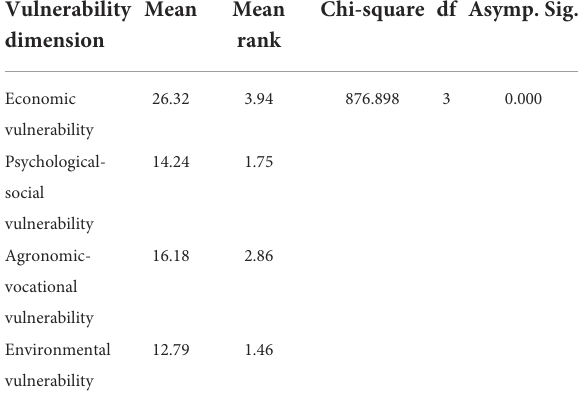
TABLE 6 The comparison of the means of the vulnerability dimensions. Vulnerability Mean Mean Chi-square df Asymp. dimension rank